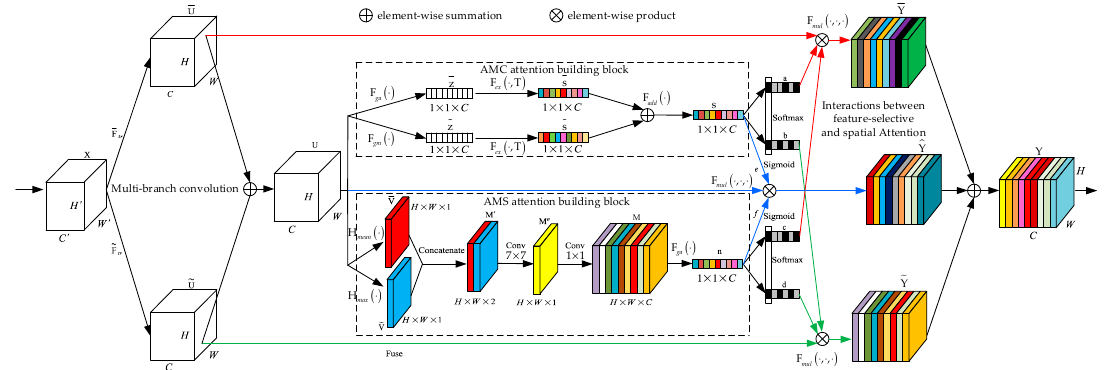
Figure 1. The structure of the “Feature-selective and Spatial Receptive Fields” (FSRF) block.